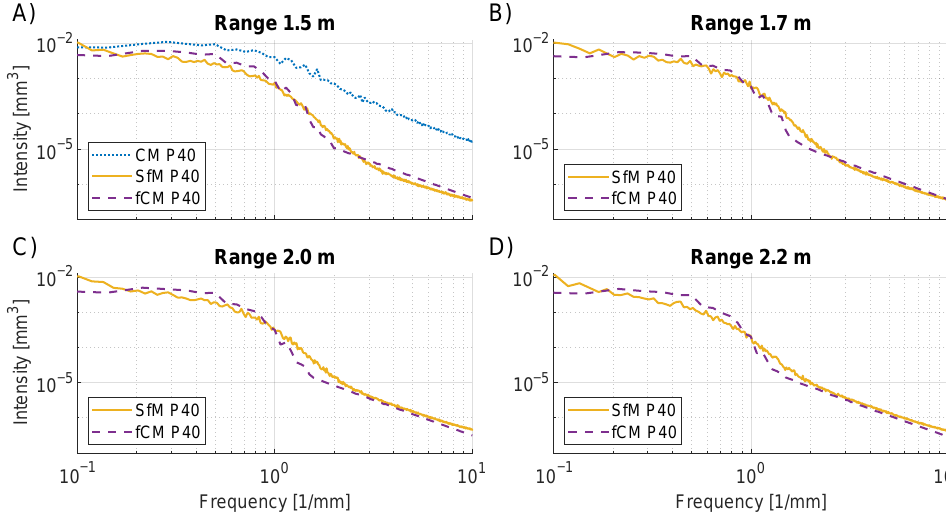
Figure 12. PSD analysis of P40 grit size at varying range or filtering level. CM (dotted line), SfM (full line), and fCM (dashed line). The average of 1D PSD curves for each line in the DEM is shown on a log–log scale. ( A ) 1.5 m. ( B ) 1.7 m. ( C ) 2.0 m. ( D ) 2.2